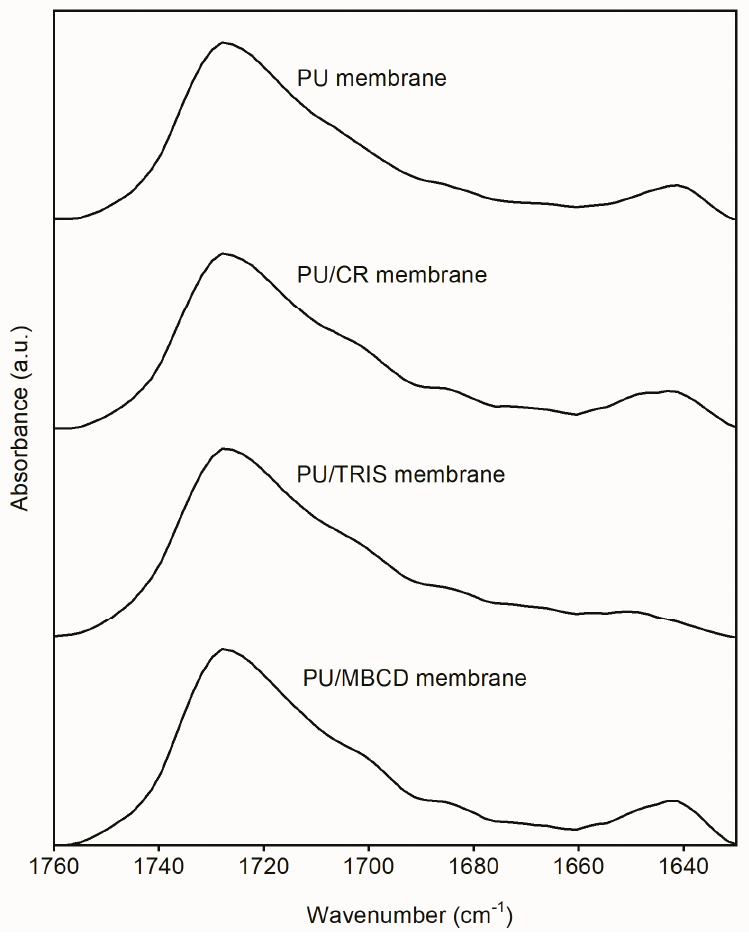
Figure 5. ATR-FTIR spectra of the carbonyl stretching region of the PU, PU/CR and PU/TRIS mem- Figure 5. branes.